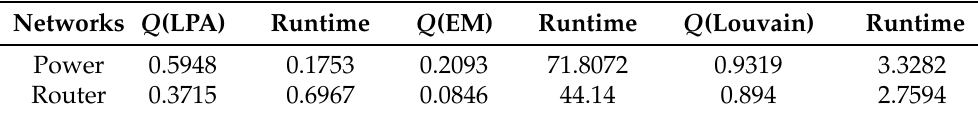
Table 6. The experimental results obtained using three classic methods in large real networks. Networks Q